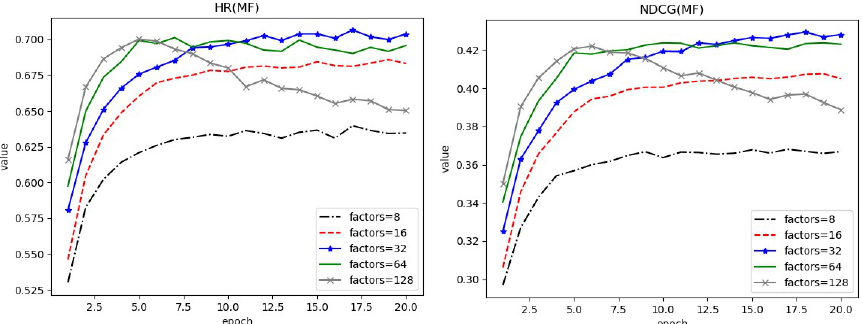
Figure 7. The HR and NDCG values for different numbers of embedding